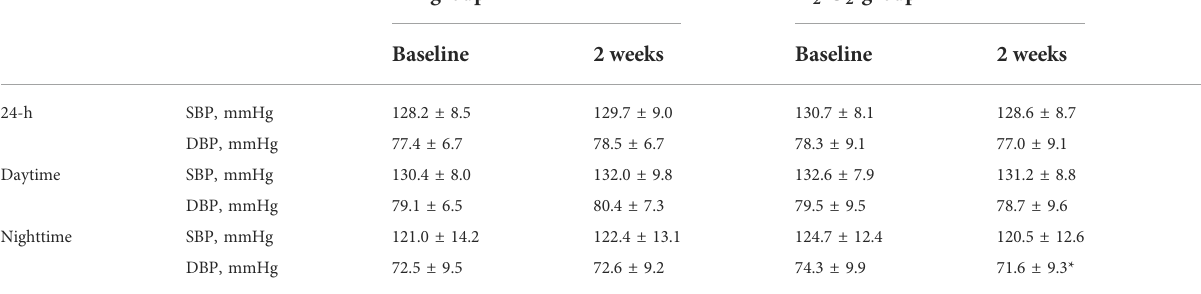
TABLE 2 Ambulatory blood